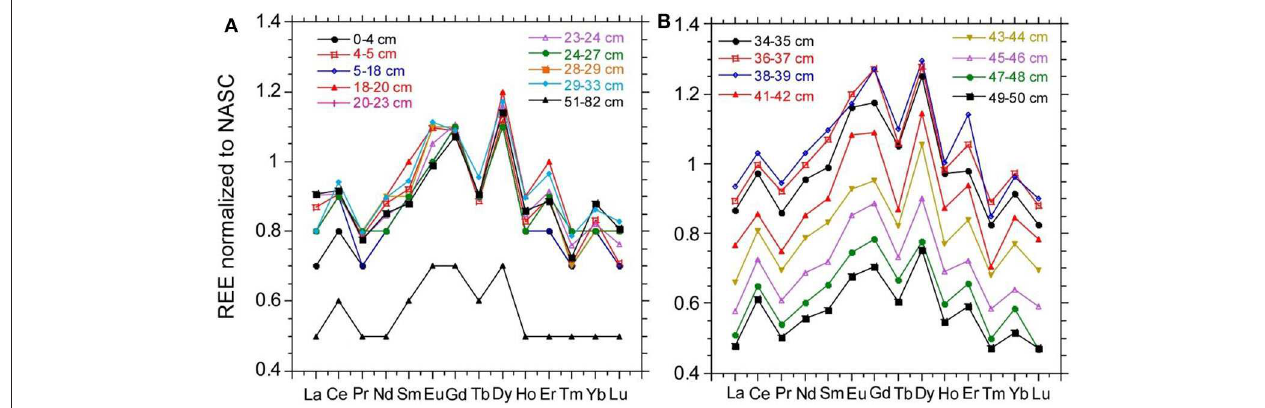
FIGURE 9 | (A,B) Rare earth element patterns normalized to chondrite at different depths in the Manzherok Lake sediment core.